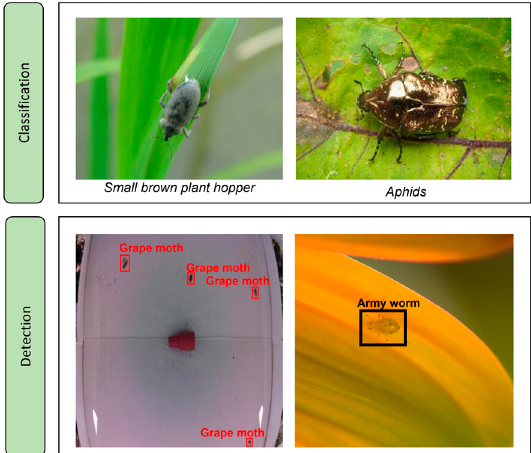
Figure 2. Examples of insect classification and detection tasks. The classification example of of small brown plant hopper and aphids on plant images. The first example of a detection task is the detection of grape moths on pheromone trap, image provided by [22]; the second example is the detection of army worm on plants images. Images with small brown plant hopper, aphids and army worm were adapted from the public dataset IP102 [42].